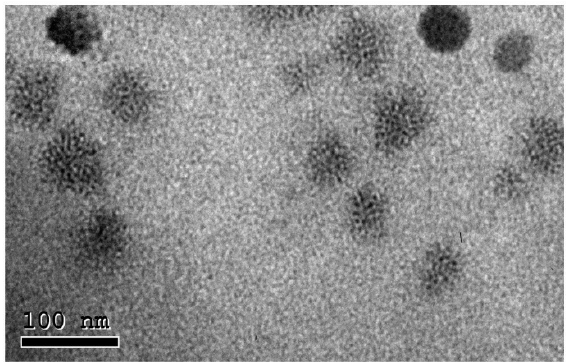
Figure 5. Morphology of the selected LPX. Abbreviation: LPX, leciplex.